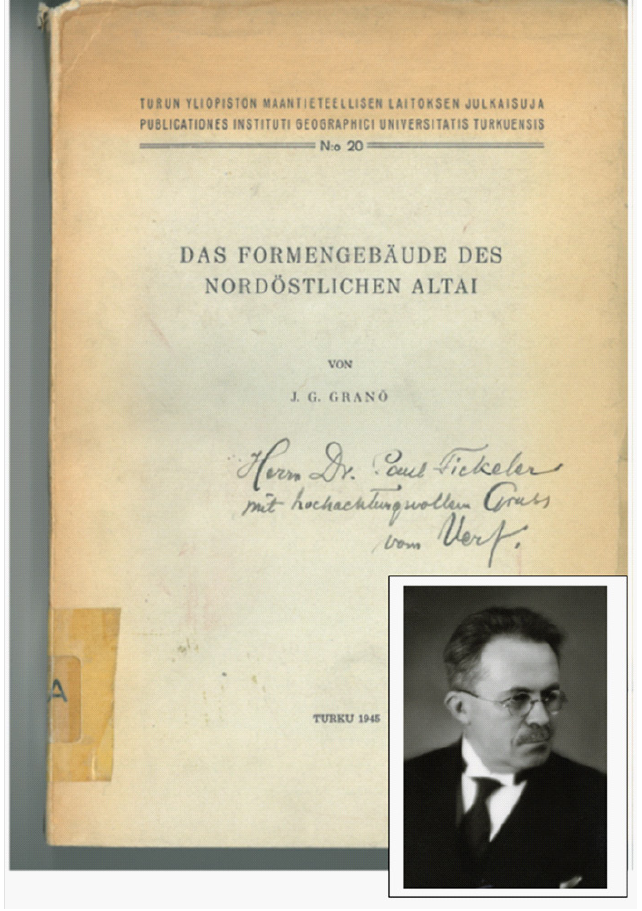
Figure 6: J.G. Granö, at the age of 61 (1943) and cover of „Das Formengebäude des nordöstlichen Altai“ with dedication to Paul